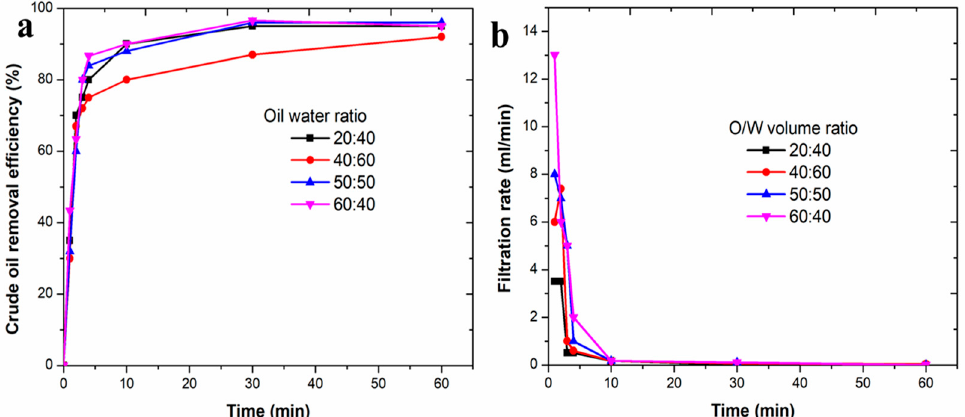
Figure 7. Effect crude oil/water volume ratio on the ( a ) oil removal efficiency and ( b ) filtration rate, operating condition: O/W = 20/80, HPAM = 50 ppm, shear rate = 5000 rpm.